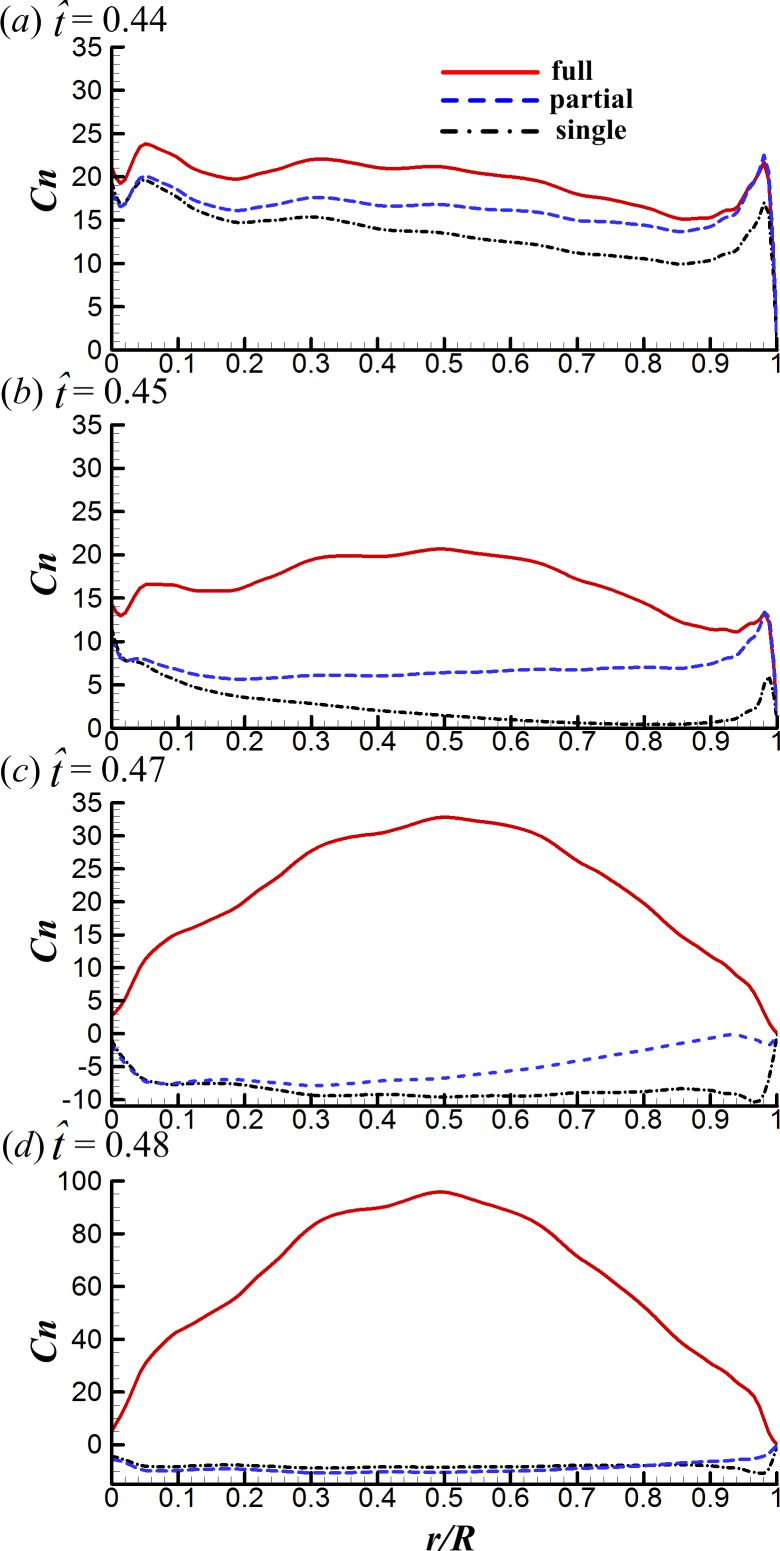
The spanwise distributions of the sectional normal force of the three cases considered at \documentclass[12pt]{minimal}
\usepackage{amsmath}
\usepackage{wasysym}
\usepackage{amsfonts}
\usepackage{amssymb}
\usepackage{amsbsy}
\usepackage{upgreek}
\usepackage{mathrsfs}
\setlength{\oddsidemargin}{-69pt}
\begin{document}
}{}$\hat {t}=0.44$\end{document}t ˆ=0.44, 0.45, 0.47 and 0.48 in the clap phase.